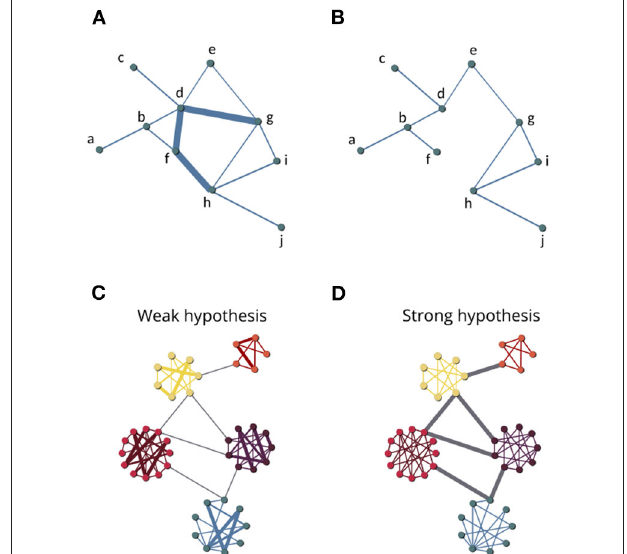
FIGURE 1 | Network model with 10 nodes before (A) and after (B) the removal of the three highest-weight links. (C) Network model representing the “weak link” hypothesis where weak acquaintance links are more likely to bridge social sub-community modules. (D) Network model representing the opposite case with local neighborhoods mainly consist of weak links, whereas strong links that bridge social sub-community modules are more important for overall